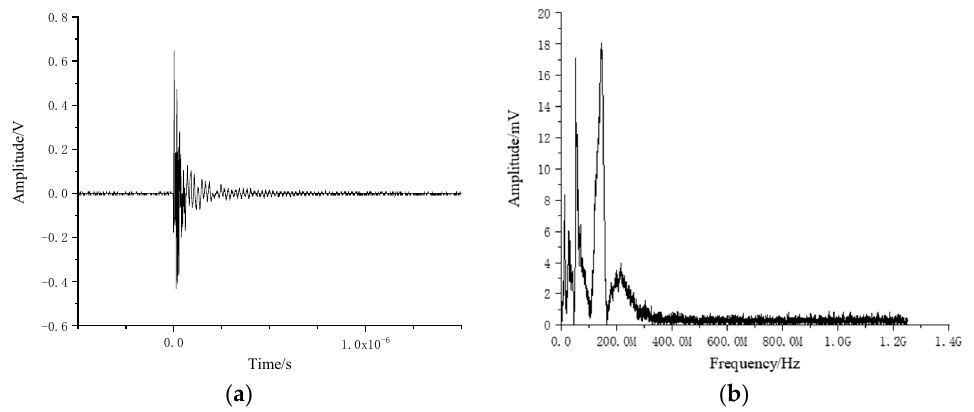
Figure 20. Magnetic field probe received PD signal. ( a ) time domain; ( b ) frequency domain.